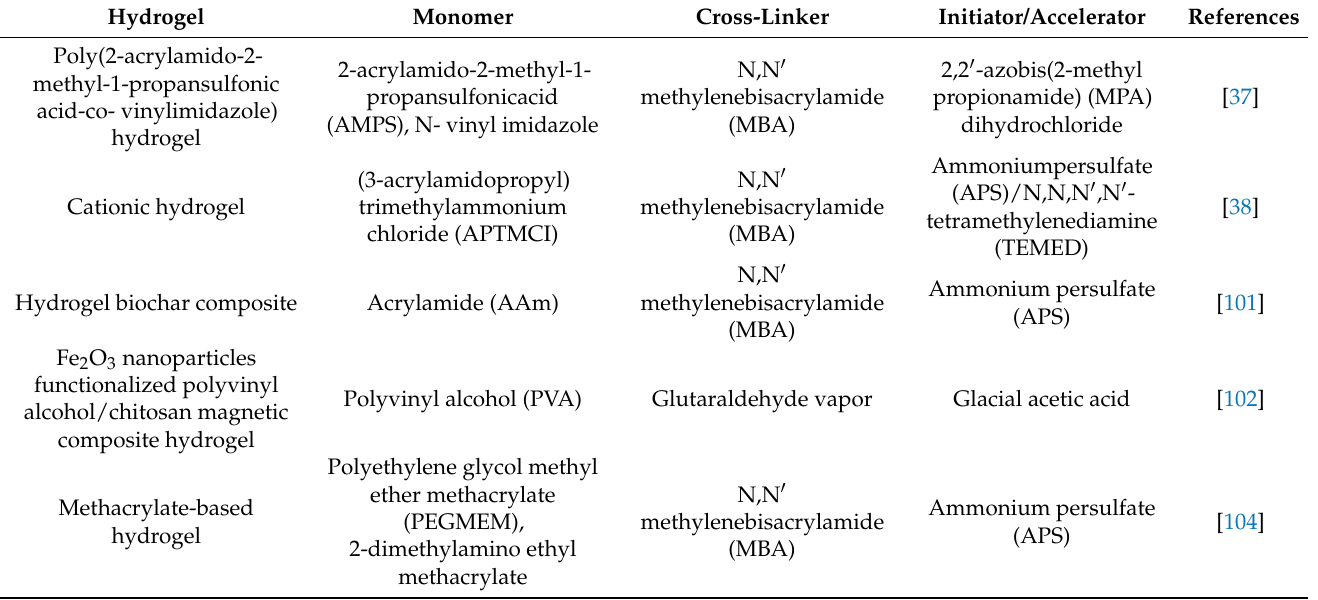
Table 4. Different hydrogel adsorbents and associated monomers, cross-linker, and initiators in the synthesis